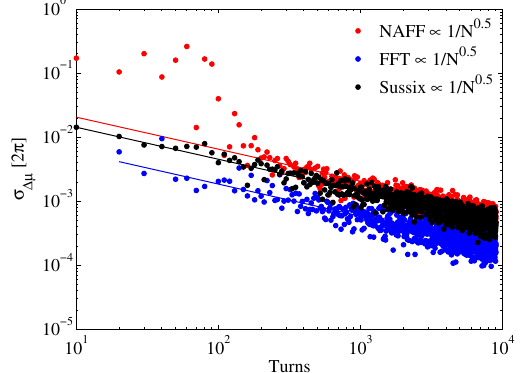
FIG. 6. Uncertainty in phase advance determination with NAFF, FFT and SUSSIX versus number of turns calculated up to N ≃ 10 4 turns considering amplitude Gaussian noise of NSR ¼ 5% . Dots are the simulated data, lines are the fits.